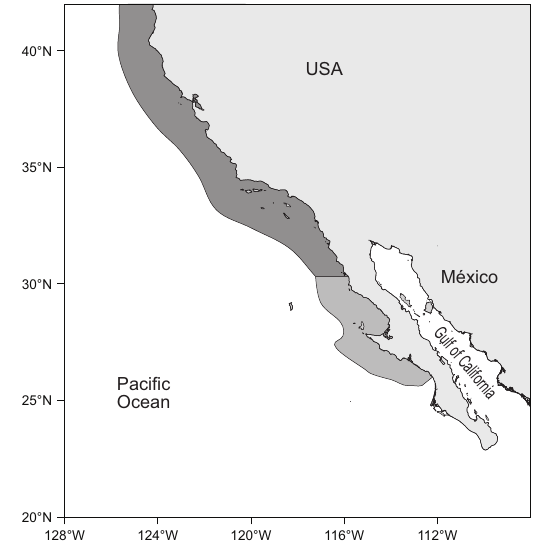
Fig. 1. Map showing the presently described range exten- sion of the coho salmon, Oncorhyncus kistuch ; The habitat expansion is of approximately 690 km; The black fringe shows the previously known distribution; last reported distribution to Camula BC ( 1 ); light grey fringe, range expansion to Las Barrancas BCS ( 2